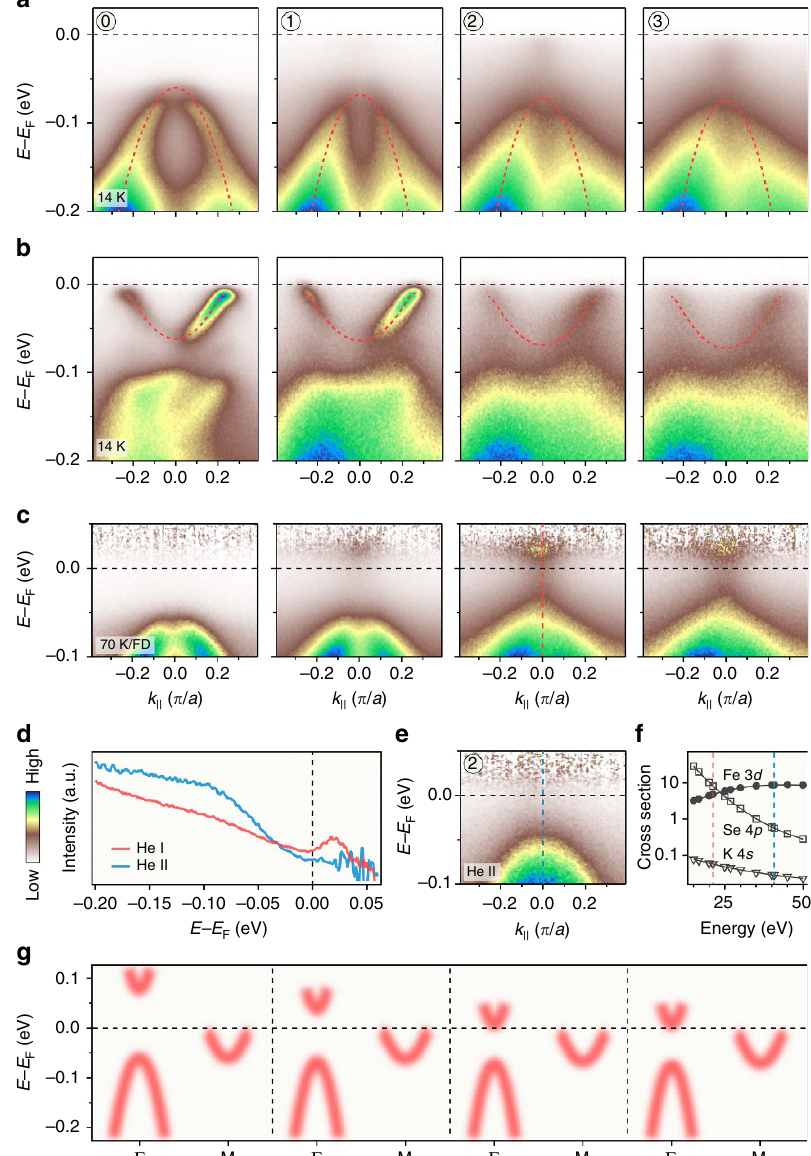
Figure 2 | Electronic band structure. ( a , b ) Potassium coating evolution of the ARPES intensity plots at 14K near G and M along the direction shown in the inset of Fig. 1e. The dashed red curves are parabolic fits to the band dispersions. ( c ) Intensity plots along the same cut as in a , but recorded at 70K. The plots are divided by the Fermi–Dirac distribution function convoluted by the resolution function to visualize the states above E F . ( e ) Intensity plot near G recorded with He II rather than He I a photons for the potassium coated sample labelled as 2. ( d ) Comparison of the EDCs at G recorded with He I a and He II beams. ( f ) Calculated atomic photonionization cross sections for Fe 3 d , Se 4 p and K 4 s . ( g ) Comparison of the band dispersions along the G –M high-symmetry line. The energy positions of the electron-like band around G are taken from the reference or estimated from the data in c . NATURE COMMUNICATIONS|8:14988|DOI: